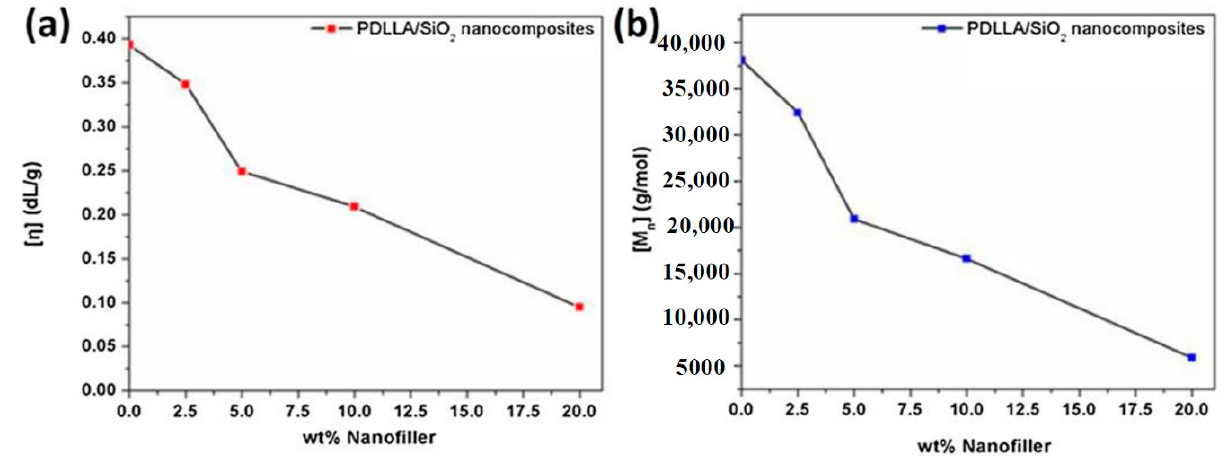
Figure 2. Effect of silica content on the ( a ) intrinsic viscosity and ( b ) average molecular weight of PDLLA [52].